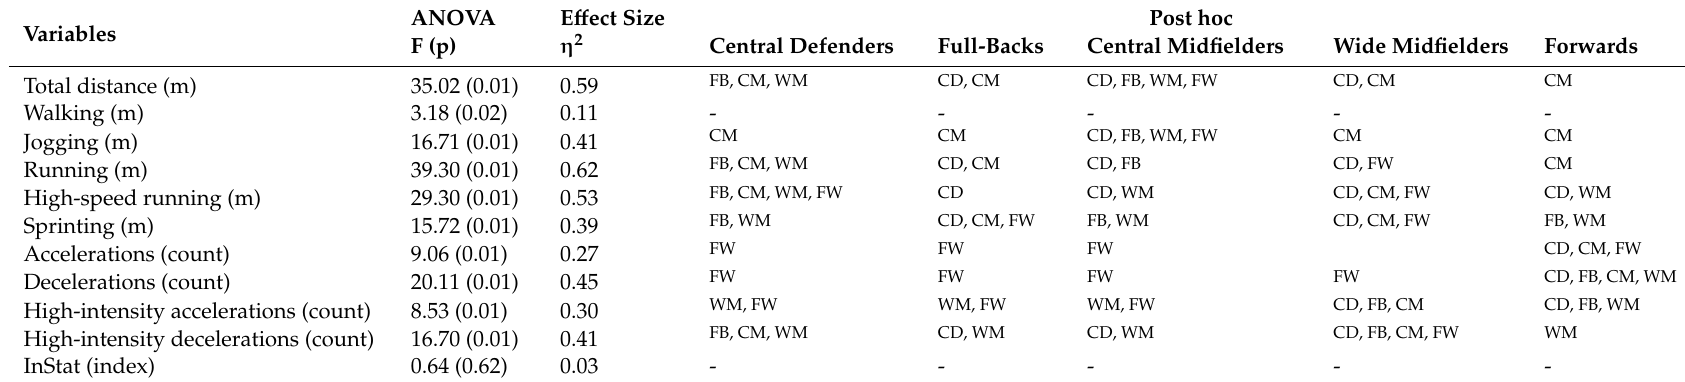
Table 3. Di ff erences among playing positions for running performances and game performance indicator (InStat) determined by analysis of variance (ANOVA), with Sche ff e post-hoc test di ff